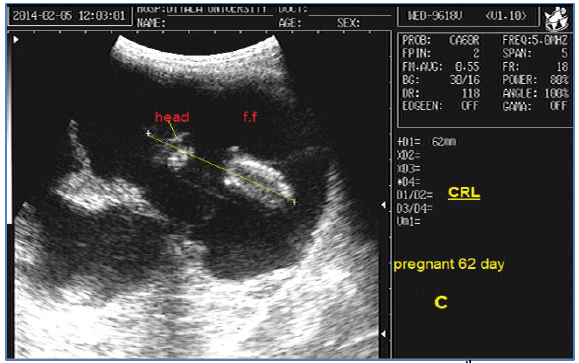
Figure, 3: Measurement of fetal CRL in 9 th week of pregnancy, indicated by straight line (Sector probe, 5MHz). f.f: fetal fluid.